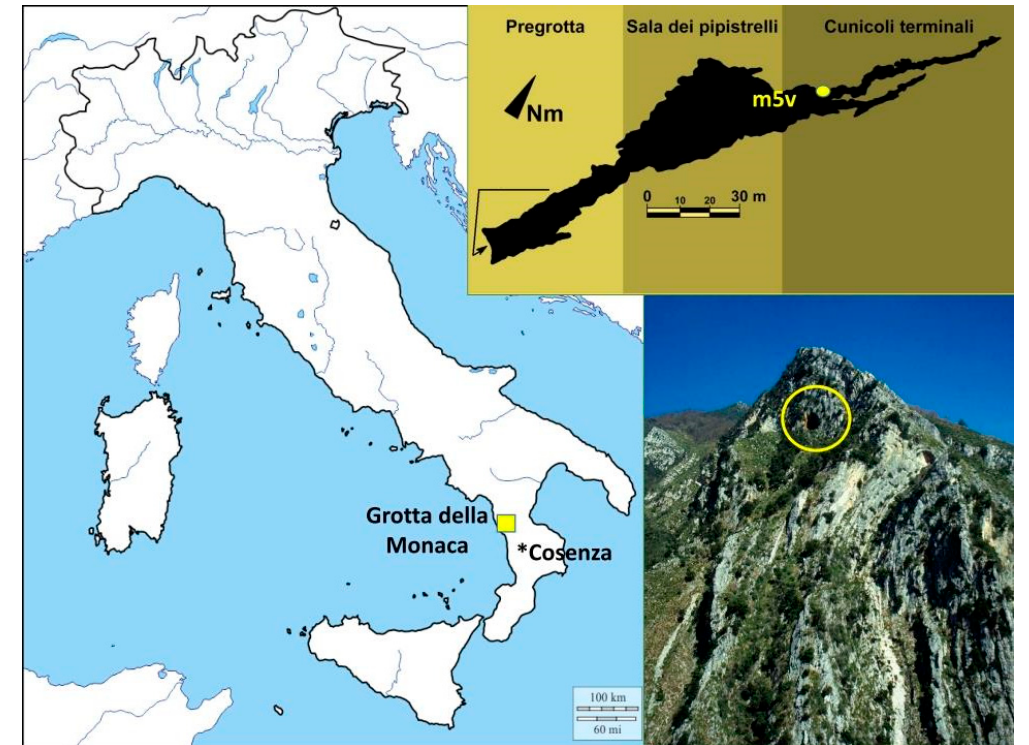
Figure 1. Location of Grotta della Monaca. The entrance of the cave is marked by a yellow circle on the bottom right image. The scheme of the cave with the m5v area is represented at the top right.